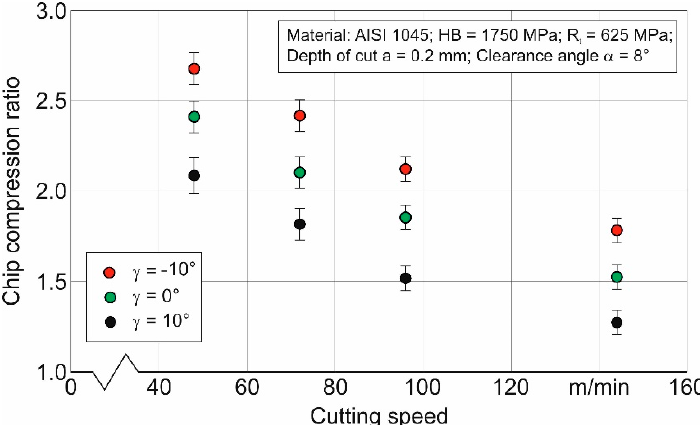
Figure 7. Changing the chip compression ratio depending on the cutting speed and the tool rake angle.